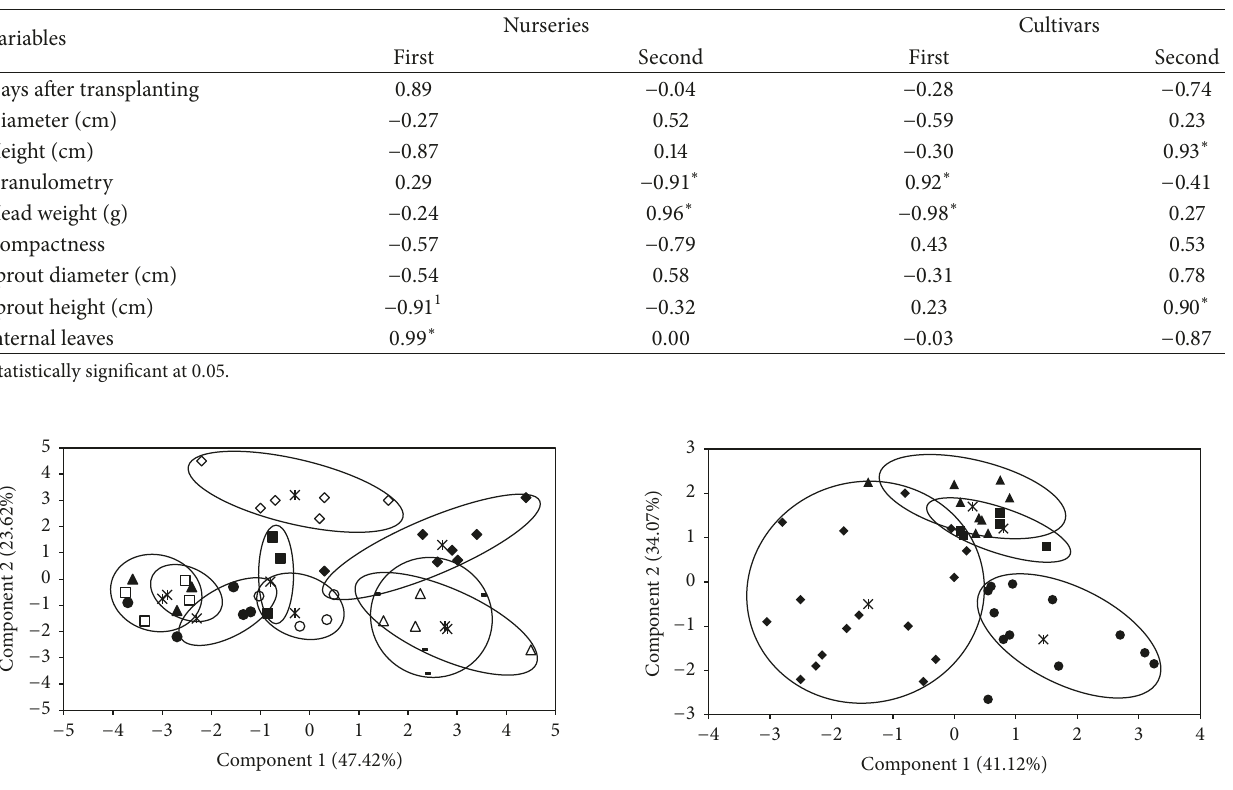
Table 6: Pearson correlation coefficients ( 𝑟 ) between phenotypical variables and PCA scores shown in Figures 1 and 2.